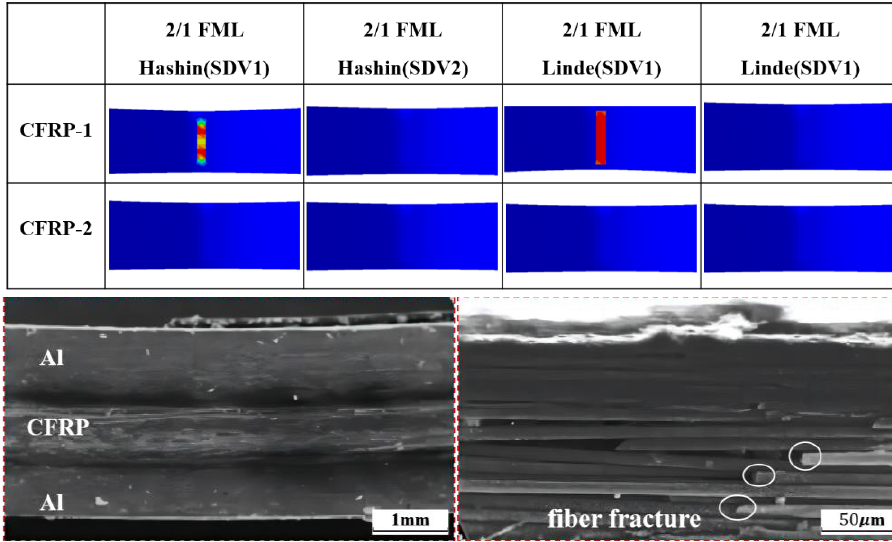
Figure 9. Damage of each CFRP layer in 2/1 FMLs